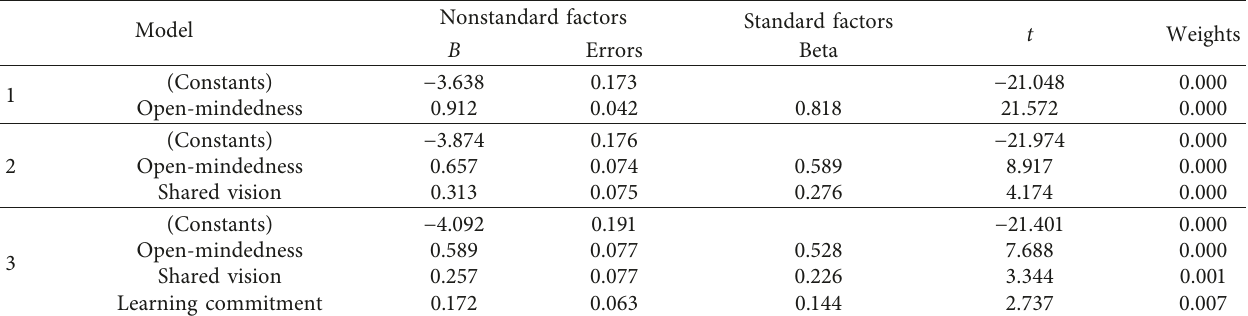
Table 6: Regression coefficient table of dynamic ability of organizational learning